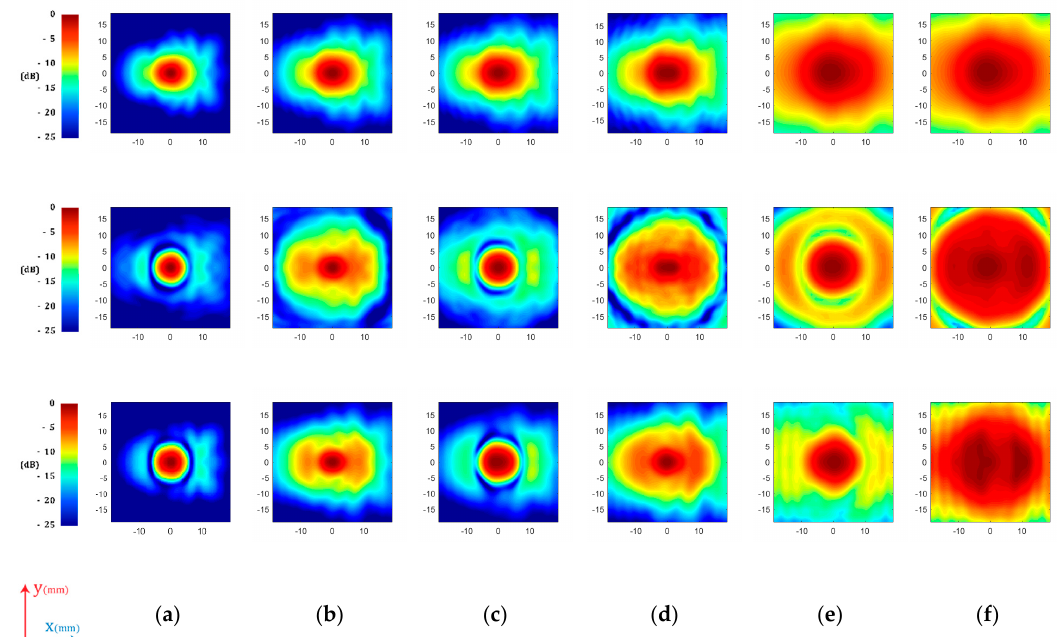
Figure 8. TPD distribution for the SPA equivalent source without (top line, scenario 5) and with PEC (middle line, scenario 6) and for the SPA (bottom line, scenario 7) normalized to its maximum at: ( a ) d = 4.75 mm; ( b ) d = 6.5 mm; ( c ) d = 7.25 mm; ( d ) d = 9.0 mm; ( e ) d = 17.25 mm; ( f ) d = 18.75 mm. The sets d = (4.75; 7.25; 17.25) mm and d = (6.5; 9.0; 18.75) mm correspond to the TPD maxima and minima, respectively.